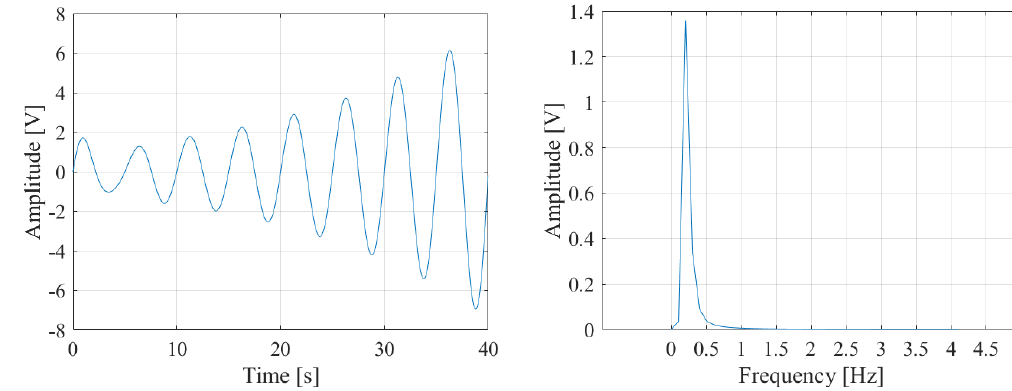
Figure 19. Time evolution ( on the left ) and spectrum ( on the right ) of the test signal adopted for the assessment.